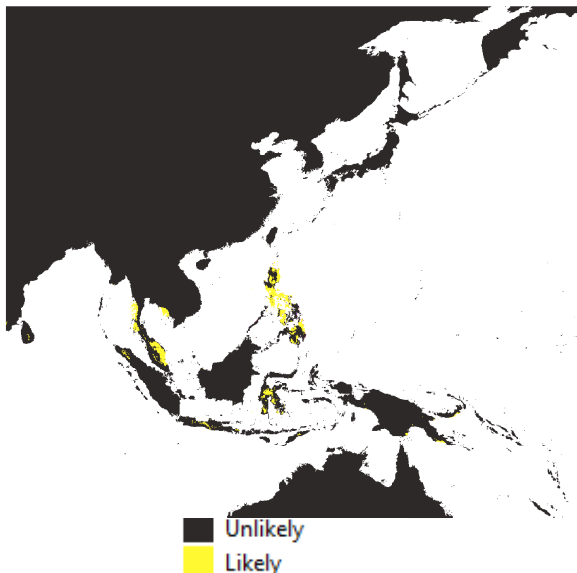
Figure 7. Binary map of the likelihood of occurrence of C.